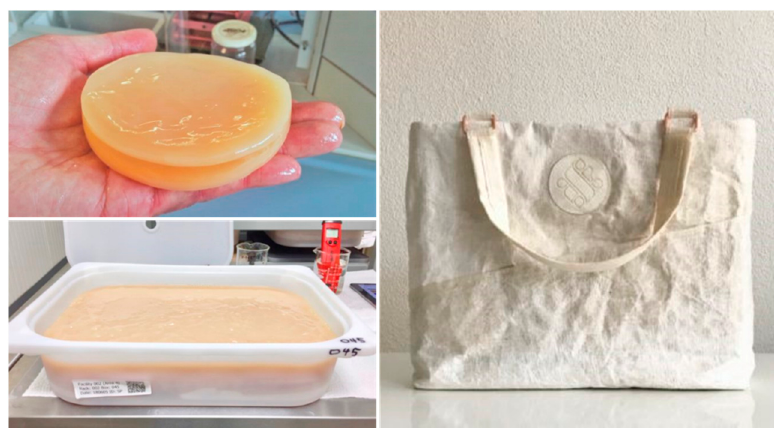
Figure 10. Leather-free handbag made of bacterial cellulose [185].